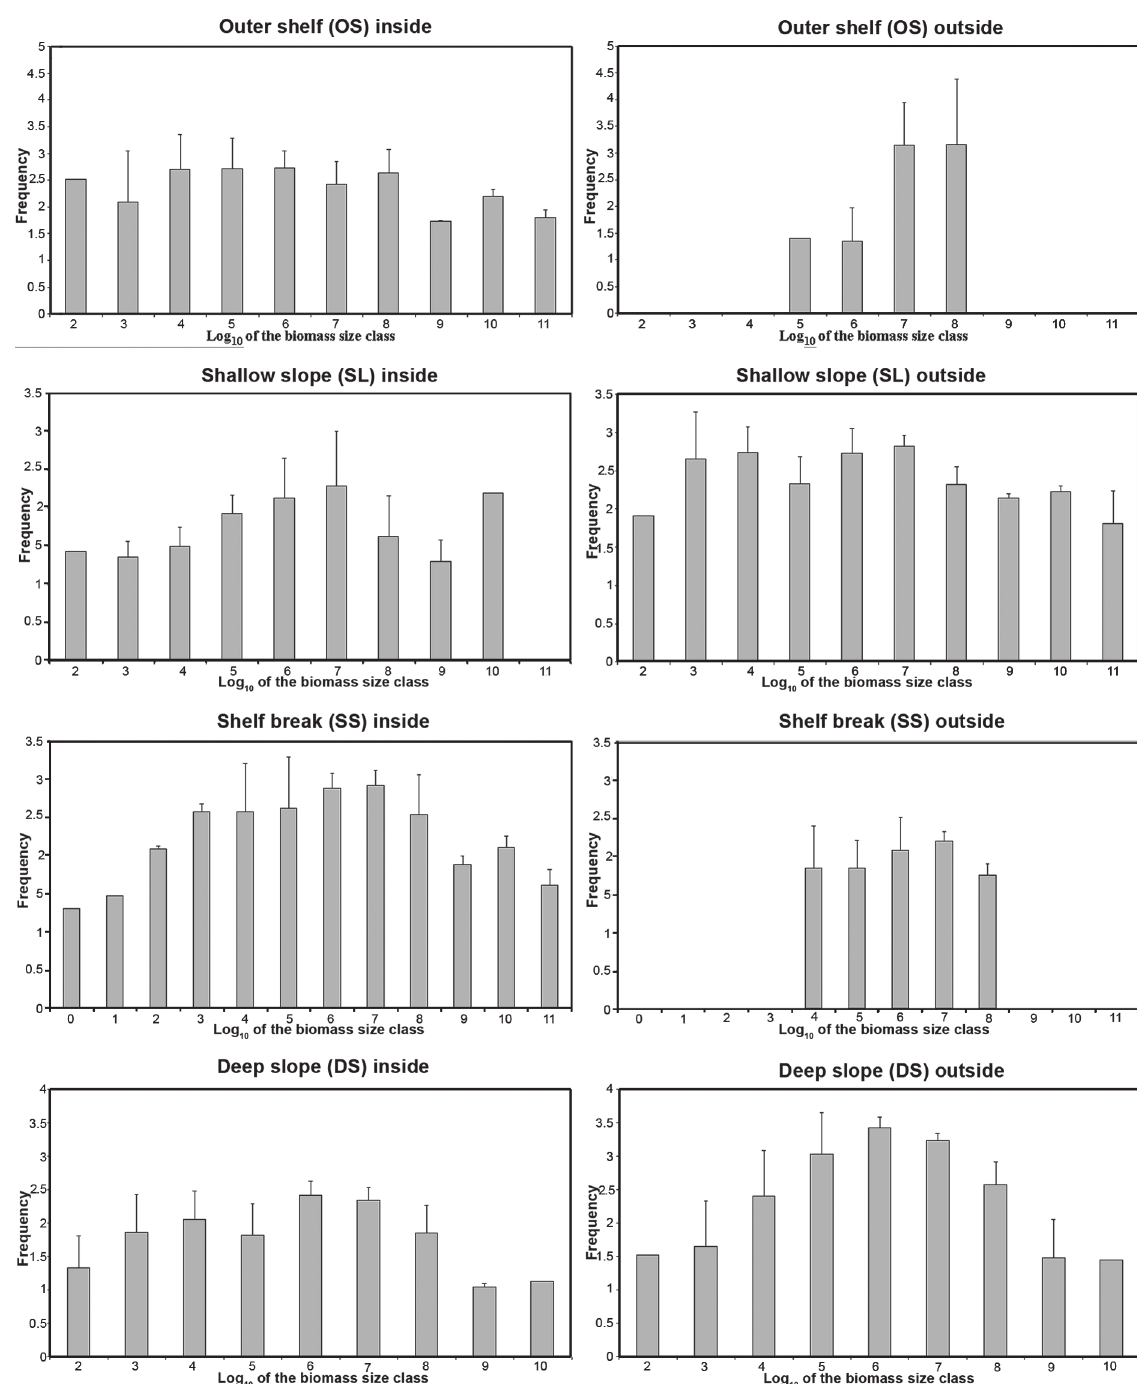
Fig 6. – Biomass size frequency distribution of elasmobranches (± 1 S.E.) by assemblage type, and inside and outside the Maltese 25 Nautical Mile Fisheries Management Zone. OS, Outer Shelf; SS, Shelf Break; SL, Shallow Slope; DS, Deep